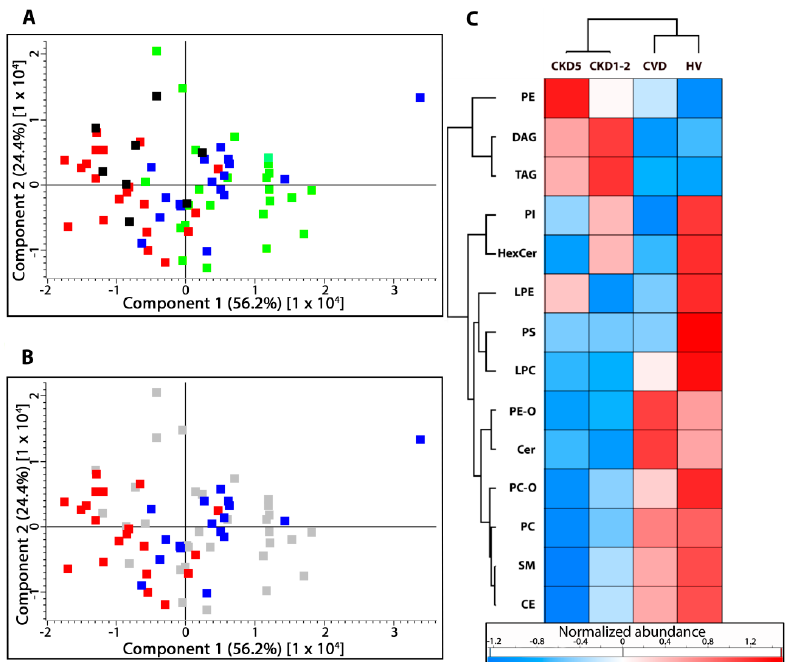
Figure 1. Unsupervised principal component analysis (PCA) performed on the total number of lipids identified in ( A ) stage 5 chronic kidney disease (CKD5) (red), cardiovascular disease (CVD) (blue), stage 1 and 2 chronic kidney disease (CKD1-2) (black), and healthy volunteers (HVs) (green) experimental groups. ( B ) To highlight the observed differences, only CKD5 (red) and CVD (blue) are marked. Other groups are presented in grey. ( C ) Hierarchical clustering analysis of identified lipid classes. PC, PC-O- phosphatidylcholines; PE, PE-O—phosphatidylethanolamines;